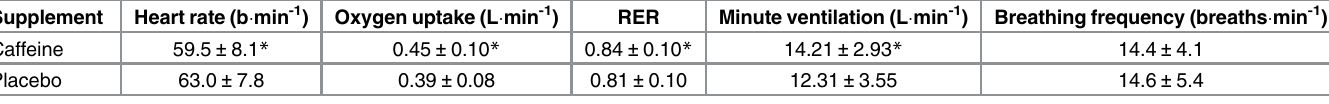
Table 1. The effects of caffeine supplementation on resting measures of heart rate, oxygen uptake, respiratory exchange ratio, minute ventilation, and breathing frequency. Values are means ± standard deviations. Supplement Heart rate (b (cid:1) min -1